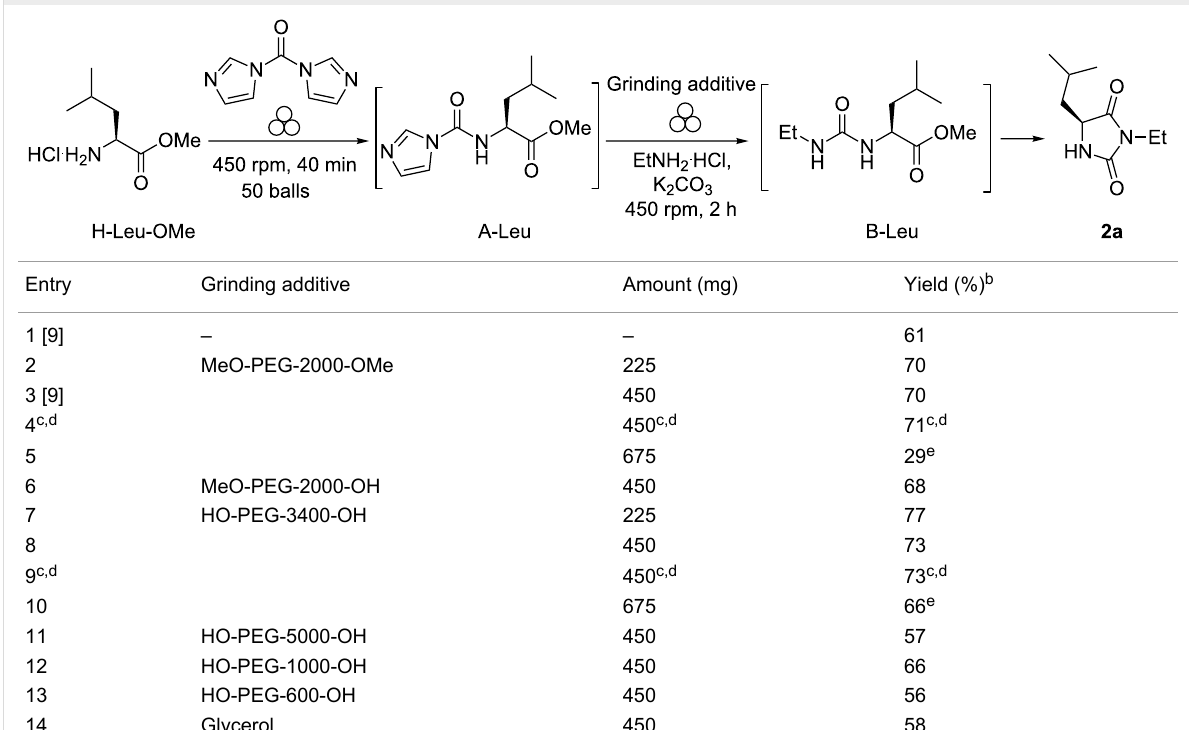
(Table 1, entry 11) or reducing (Table 1, entries 12 and 13) the polymer chain length, changing the end terminal substitu- ents (Table 1, entries 6 vs 3), and adding glycerol instead